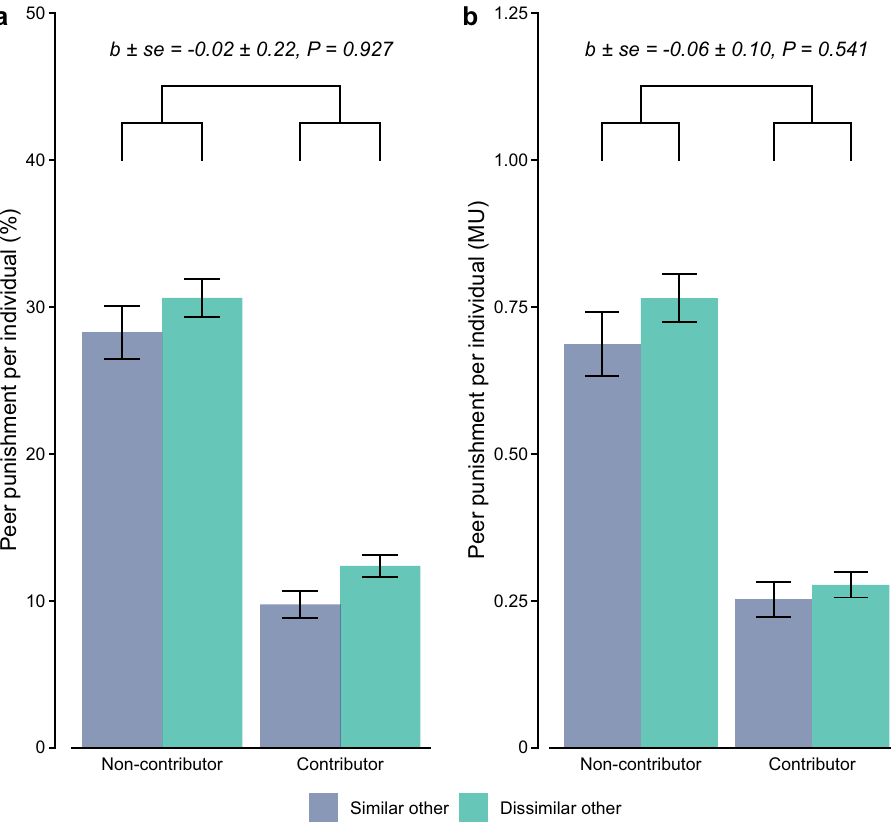
Figure 2. Punishment of non-contributors and contributors in the pluriform group. ( a ) Mean (± se ) frequency of peer punishment and ( b ) mean (± se ) expenditure on peer punishment (per individual), as a function of target’s contribution and target’s